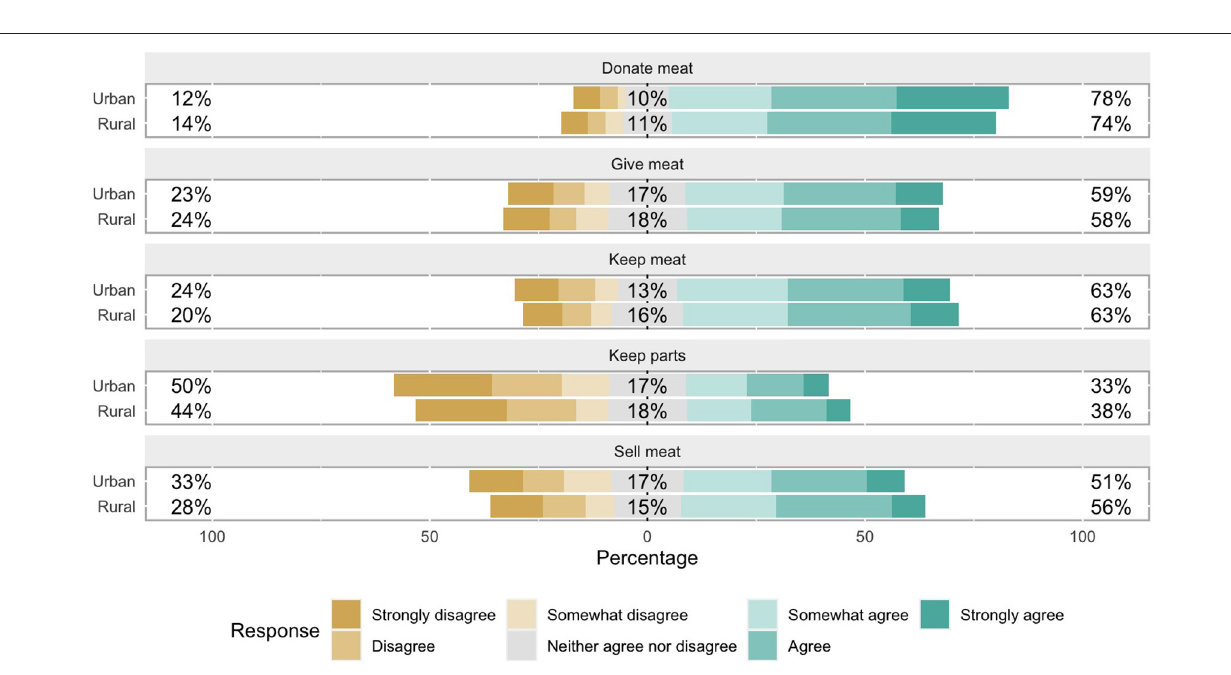
FIGURE 5 | Acceptability of people who shoot deer using parts of the deer in various ways, split by urban and rural respondents. Bars show distribution of responses, colored by disagreement (browns), indifference (gray), and agreement (greens). Percentages show proportions of respondents who disagreed (left), were indifferent (middle), or agreed (right) that each use was acceptable, after excluding “I don’t know”